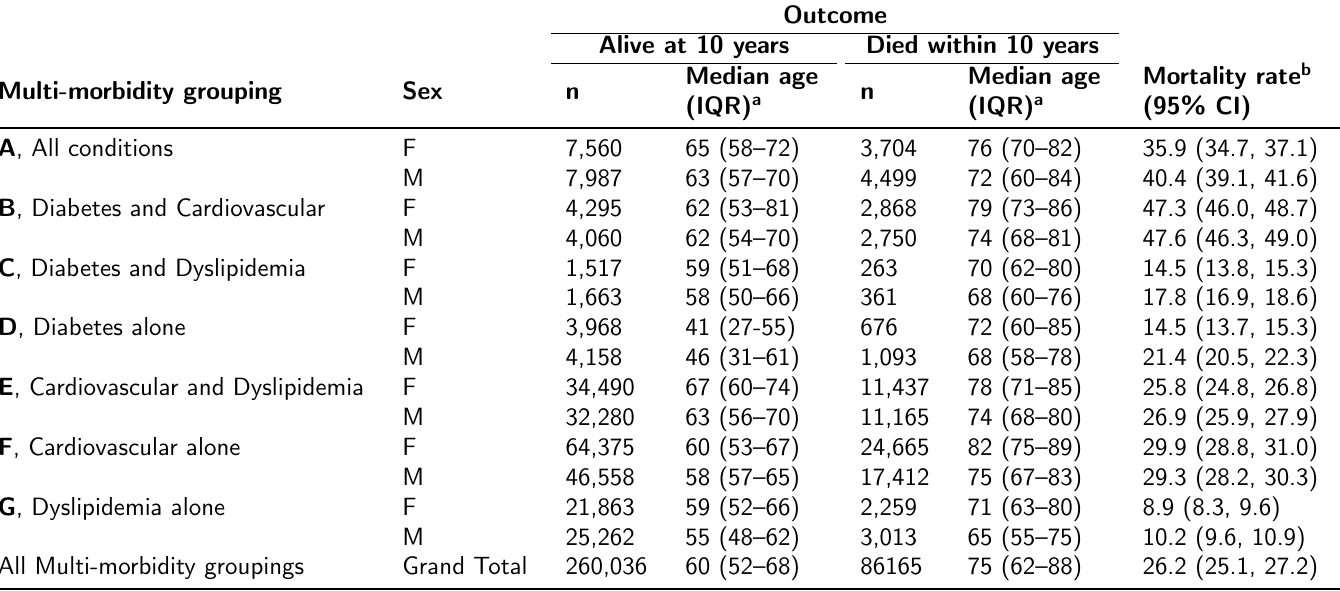
Table 2: Crude mortality rate for diabetes associated multi-morbidity